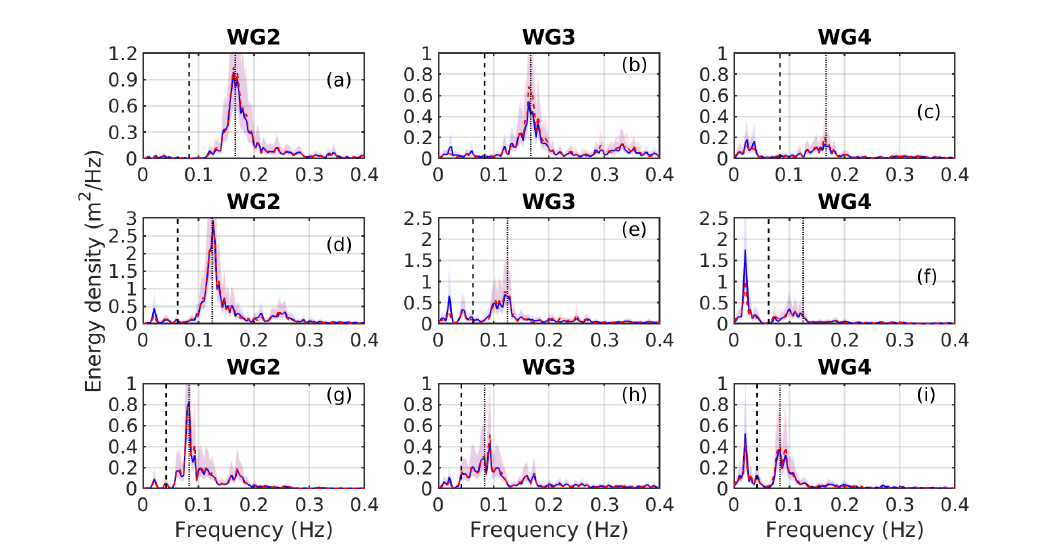
Figure 4. Comparisons between the observed (red dashed line; mostly obstructed) and computed (blue solid line) spectra at the three wave gauge locations for case DR0 ( a – c ), SBE2 ( d – f ), and SBA1 ( g – i ). The vertical dotted line represents the peak frequency and the black dashed line represents the frequency cutoff between the SW and IG band. Shaded areas define the 95% confidence intervals. The bathymetric profile was assumed fixed in the numerical computation for each of the three